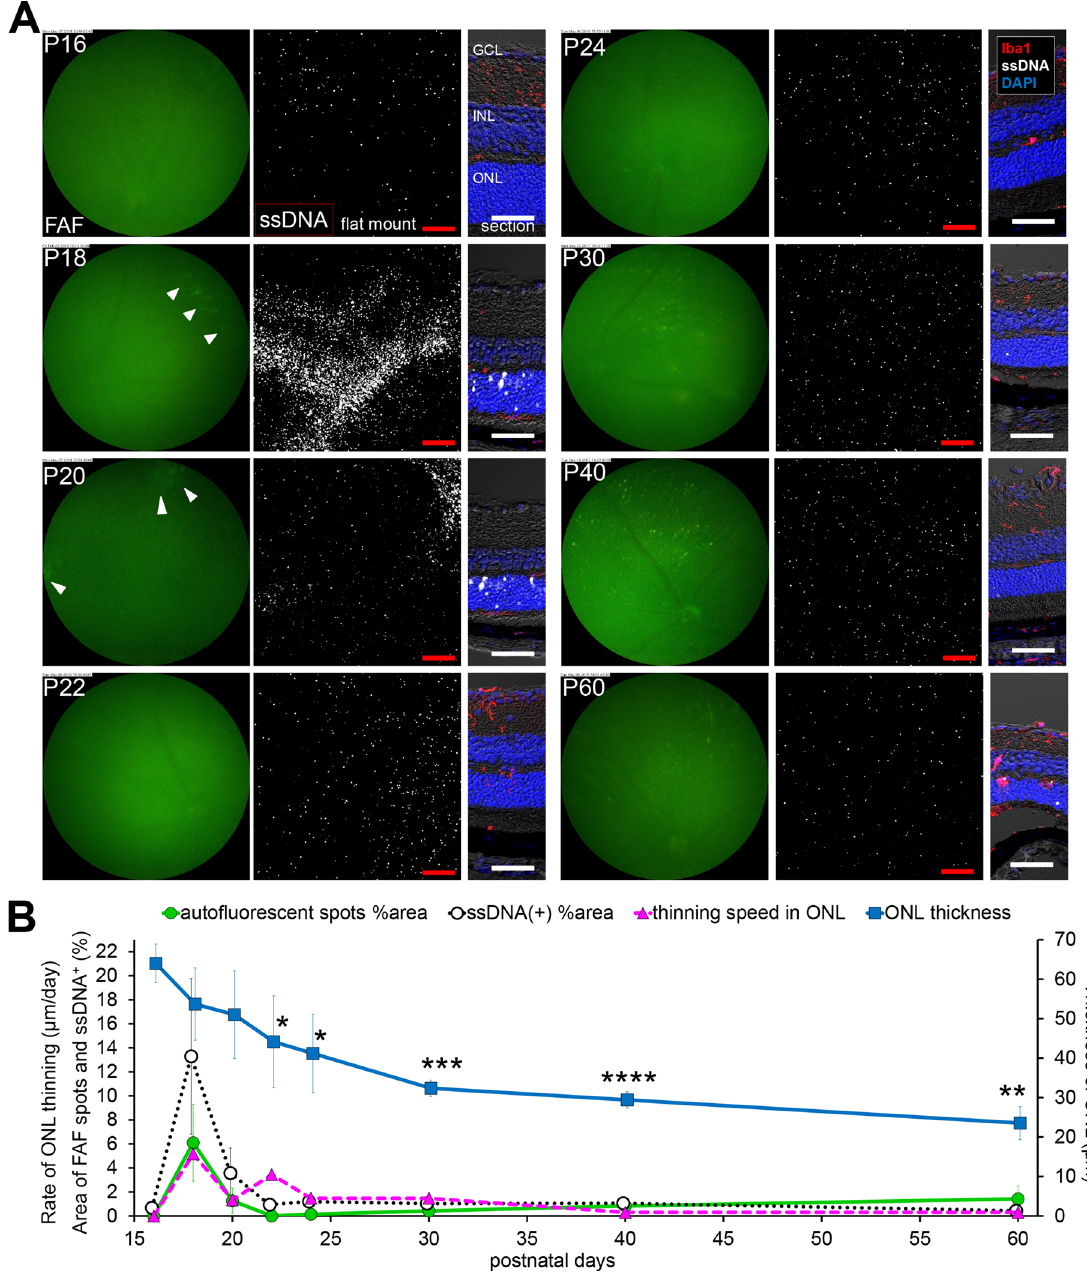
Figure 5. Relationship in fundus autofluorescent spots, apoptosis of photoreceptors and retinal ONL thickness in the peripheral retina of rd10 raised in dark. ( A ) Pictures show the time course change from P16 to P60, in the peripheral retina of rd10 raised in dark. Left pictures are in vivo FAF imaging with a retinal imaging microscope. Middle pictures show the confocal images of extracted flat-mounted retina at the ONL level, labeled with ssDNA (white). Scale bars, 100 μm. Right pictures show the retinal section labeled with DAPI (blue), ssDNA (white) and Iba1 (red). Scale bars, 50 μm. Arcuate FAF spots emerged from P18 to P20 (arrowhead). Arcuate aggregates of ssDNA + cells also emerged from P18 to P20. ( B ) The graphs show the quantification of the FAF spot area % (green line), the ssDNA + area % (black line), the thickness of the ONL (blue line) and thinning rate of the ONL (magenta line). The markers of the graph show mean and SD (n = 4). (* p < 0.05, ** p < 0.0005, *** p < 0.00005, **** p < 0.000005, t test in comparison to the central retina raised in dark). The appearance of arcuate FAF spots peaked on P18. The peak of the thinning rate of the ONL, appearance of the FAF spots and apoptosis were observed synchronously on P18. Thinning of ONL in the peripheral retina was significantly more progressed compared to the central retina of the group raised in